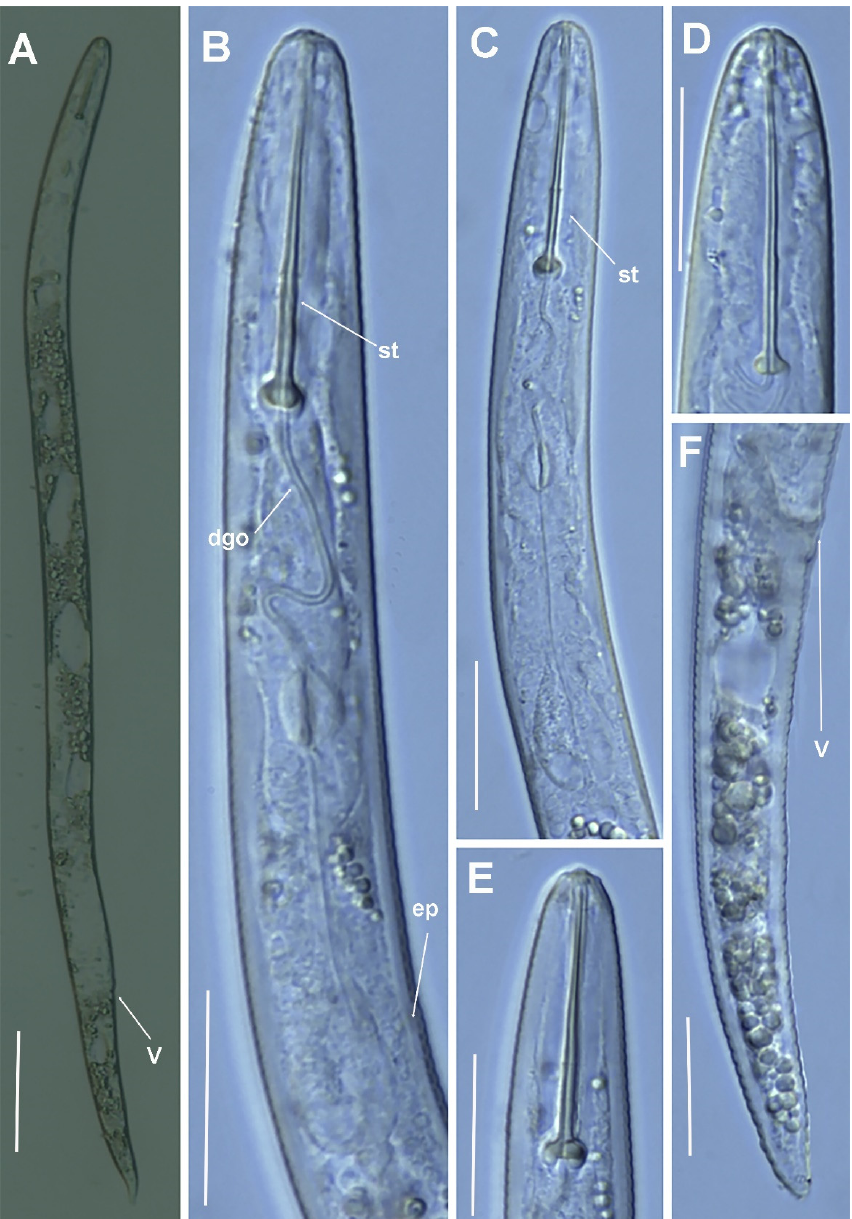
Figure 12. Micro-photomicrographs of Paratylenchus sp. 2 SAS female. ( A ) Whole female with vulva arrowed; ( B , C ) Pharyngeal region; ( D , E ) Detail of female stylet region; ( F ) Female posterior region with vulva (arrowed). Scale bars ( A = 50 μ m; B–F = 20 μ m). (Abbreviations: dgo = dorsal gland orifice; ep = excretory pore; st = stylet; V = vulva).